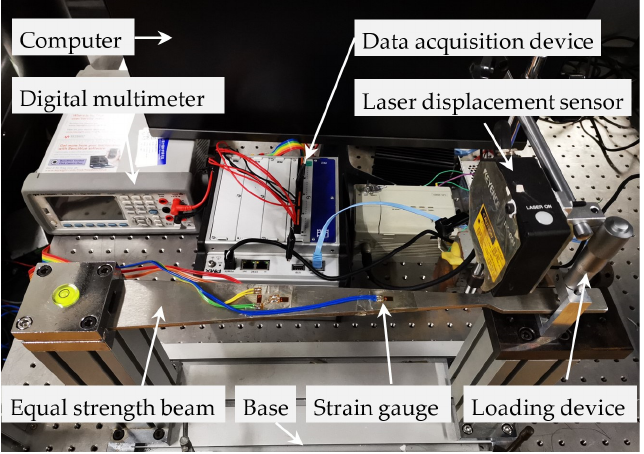
Figure 14. Experimental setup for the strain measurement of the equal strength beam.